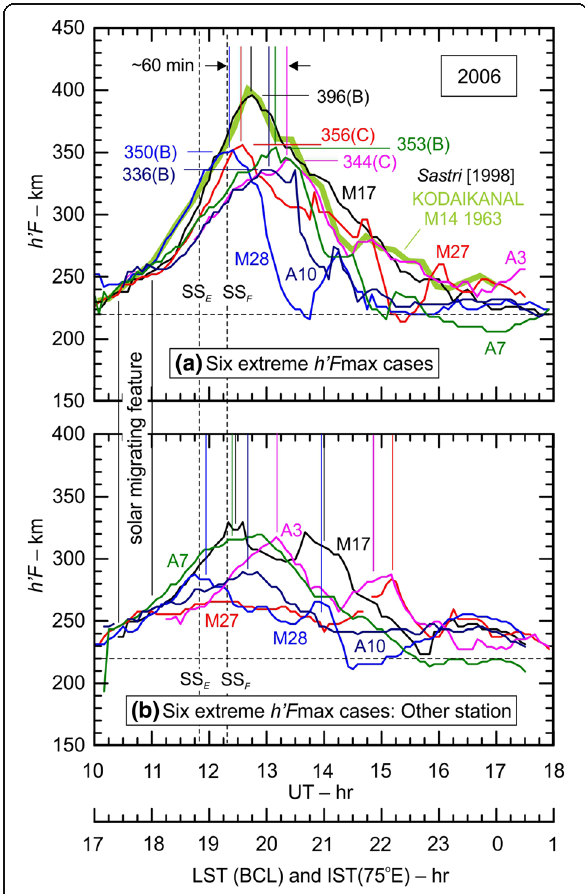
Fig. 16 a Curves of h ’ (2.5) from six nights, which can be classified as ‘ extreme ’ events, observed over CPN or BCL, are plotted with the h ’ F curve for a single ‘ extreme ’ event over Kodaikanal (Sastri,